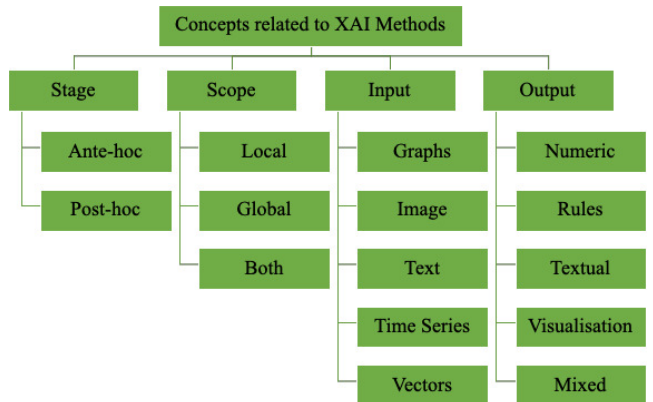
Figure 3. Overview of the different concepts on developing methodologies for XAI, adapted from the review studies by Vilone and Longo